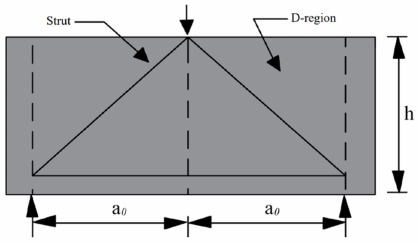
Figure 1. Schematic diagram of deep beam